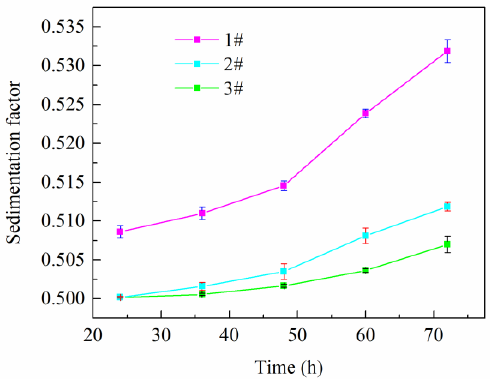
Figure 9. Changes in the sedimentation factors of different OBDFs over time (error bars represent standard deviation). The standard deviation values range from 9.4 × 10 −5 to 1.5 × 10 −3 based on TQ- 1 concentration and sedimentation